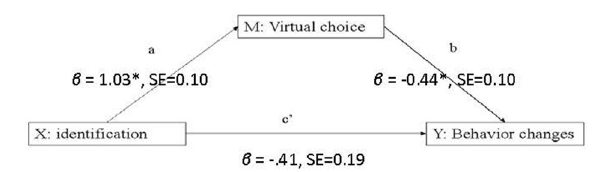
TABLE 2 | Path coefficients, SE, and 95% CI.